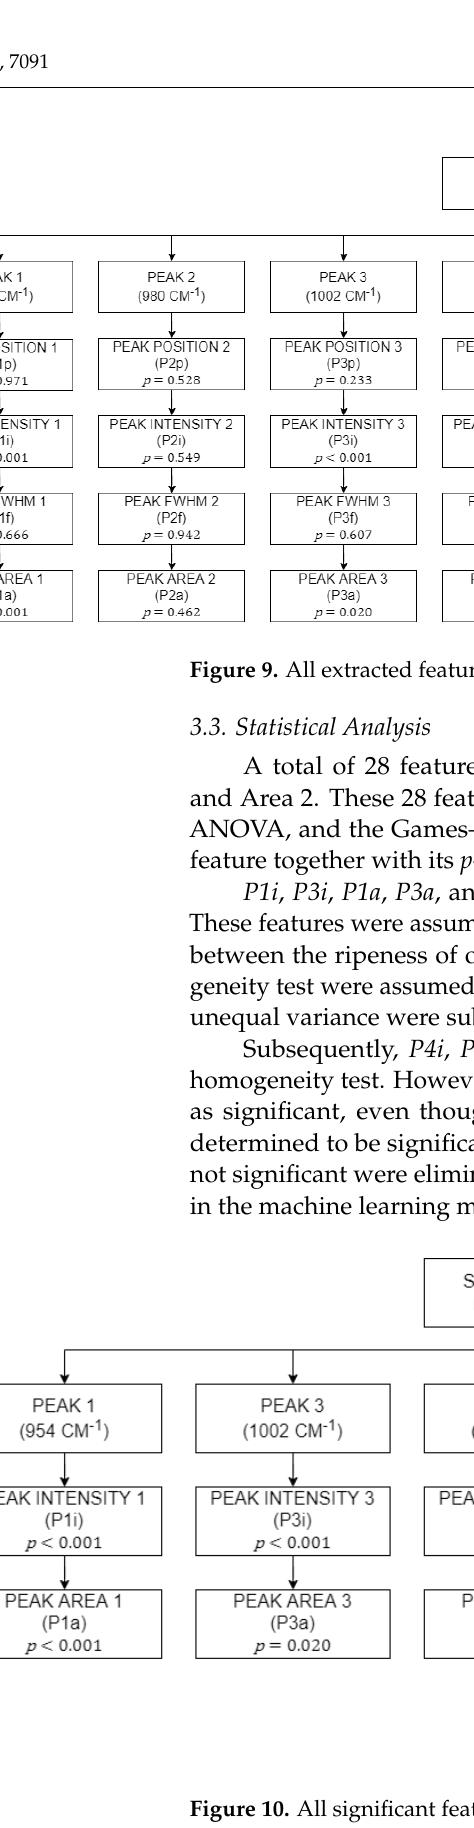
Figure 10. All significant features after statistical